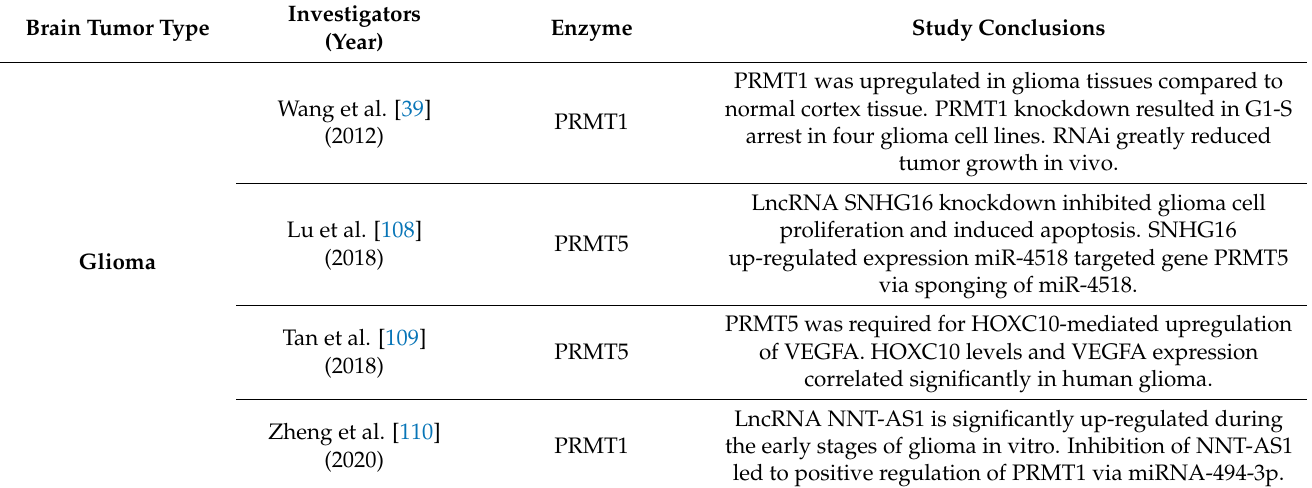
Table 1. Summary of studies associating PRMT activity with brain tumorigenesis. GBM = Glioblastoma; VEGFA = Vascular endothelial growth factor-A; LncRNA = Long non-coding RNA. Brain Tumor